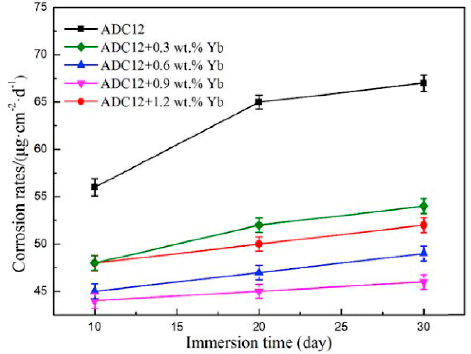
Figure 6. Weight loss rate curves of ADC12-xYb aluminum alloys immersed in 3.5 wt % NaCl solution for 10, 20, 30 days. Reprinted with permission from Elsevier